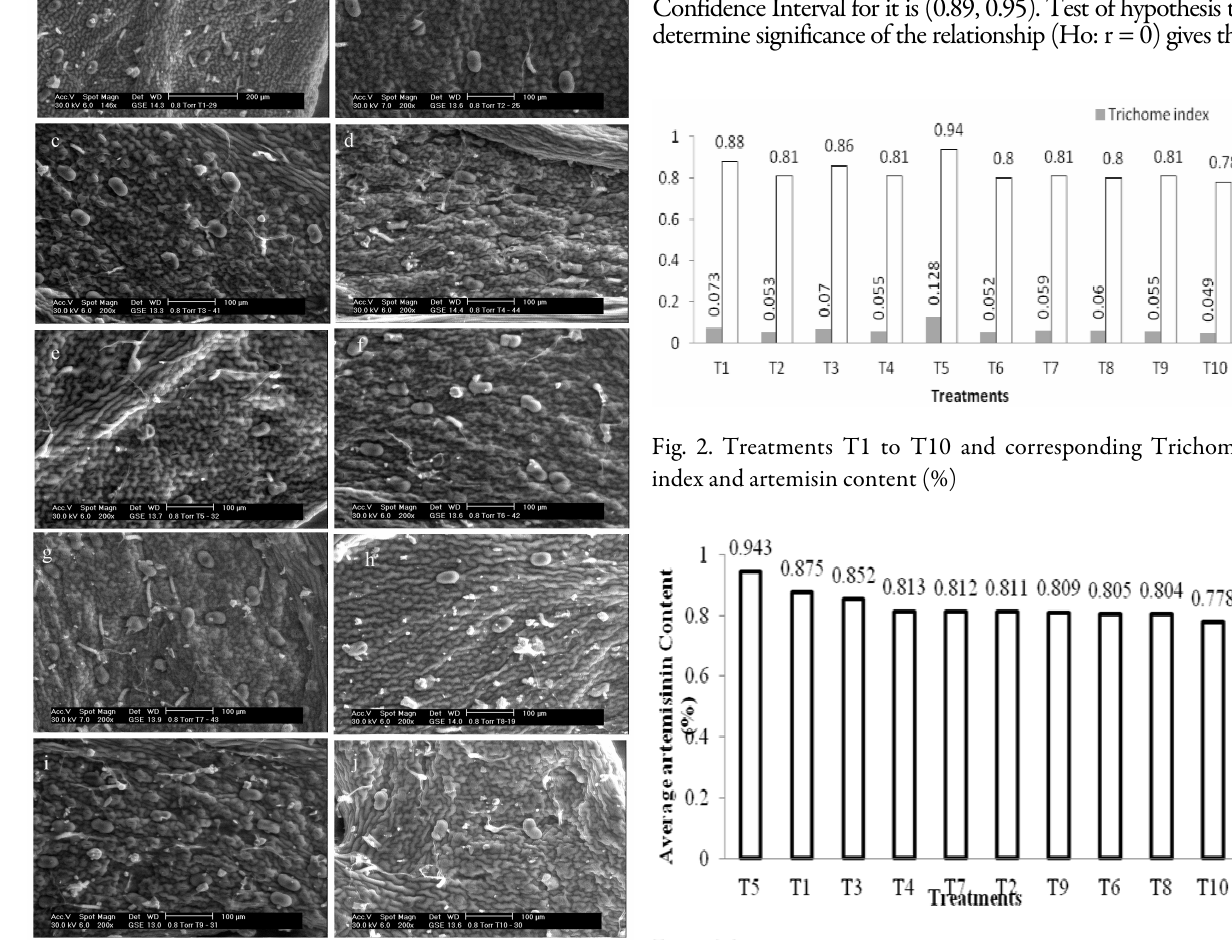
Fig. 3. Mean artemisinin content